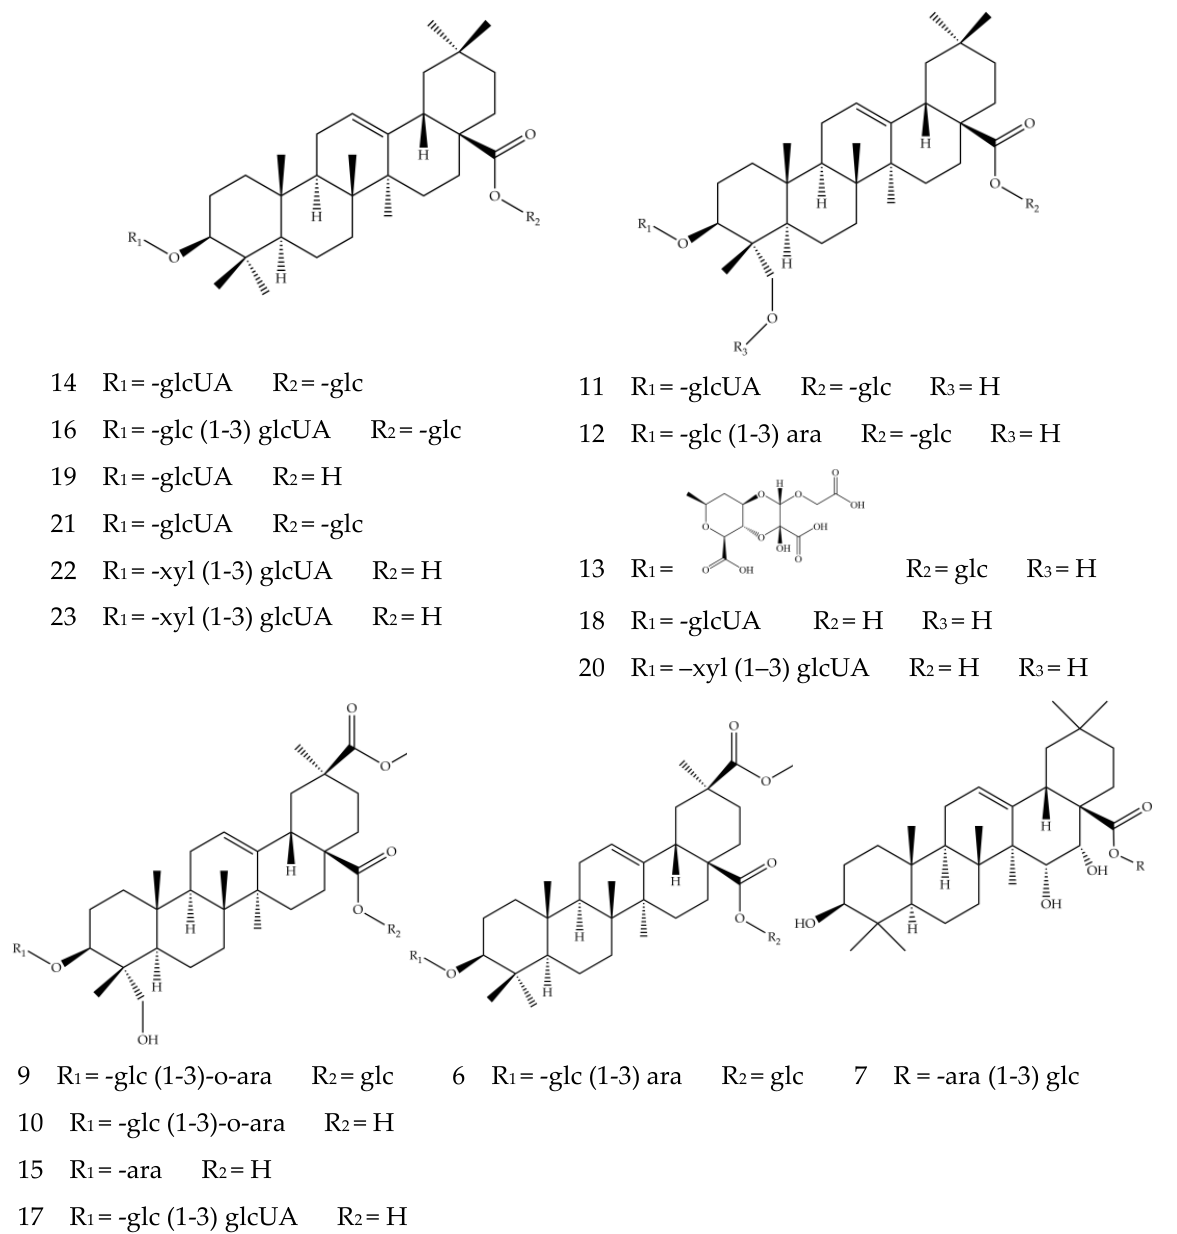
Figure 4. The structures of Compounds 6 – 7 and 9 – 23.